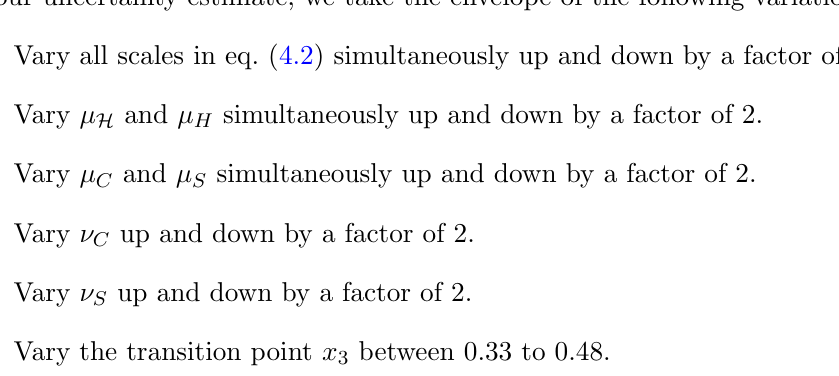
Figure 7 . The di(cid:11)erential jet shape at order (cid:11) s for quark jets (left) and gluon jets (right) at p T = 600 GeV and R = 0 : 6. Shown are (cid:26) r . R (red solid), decomposed in its singular (cid:26) r dashed) and nonsingular (green dotted) contribution that correspond to the power corrections in eq.